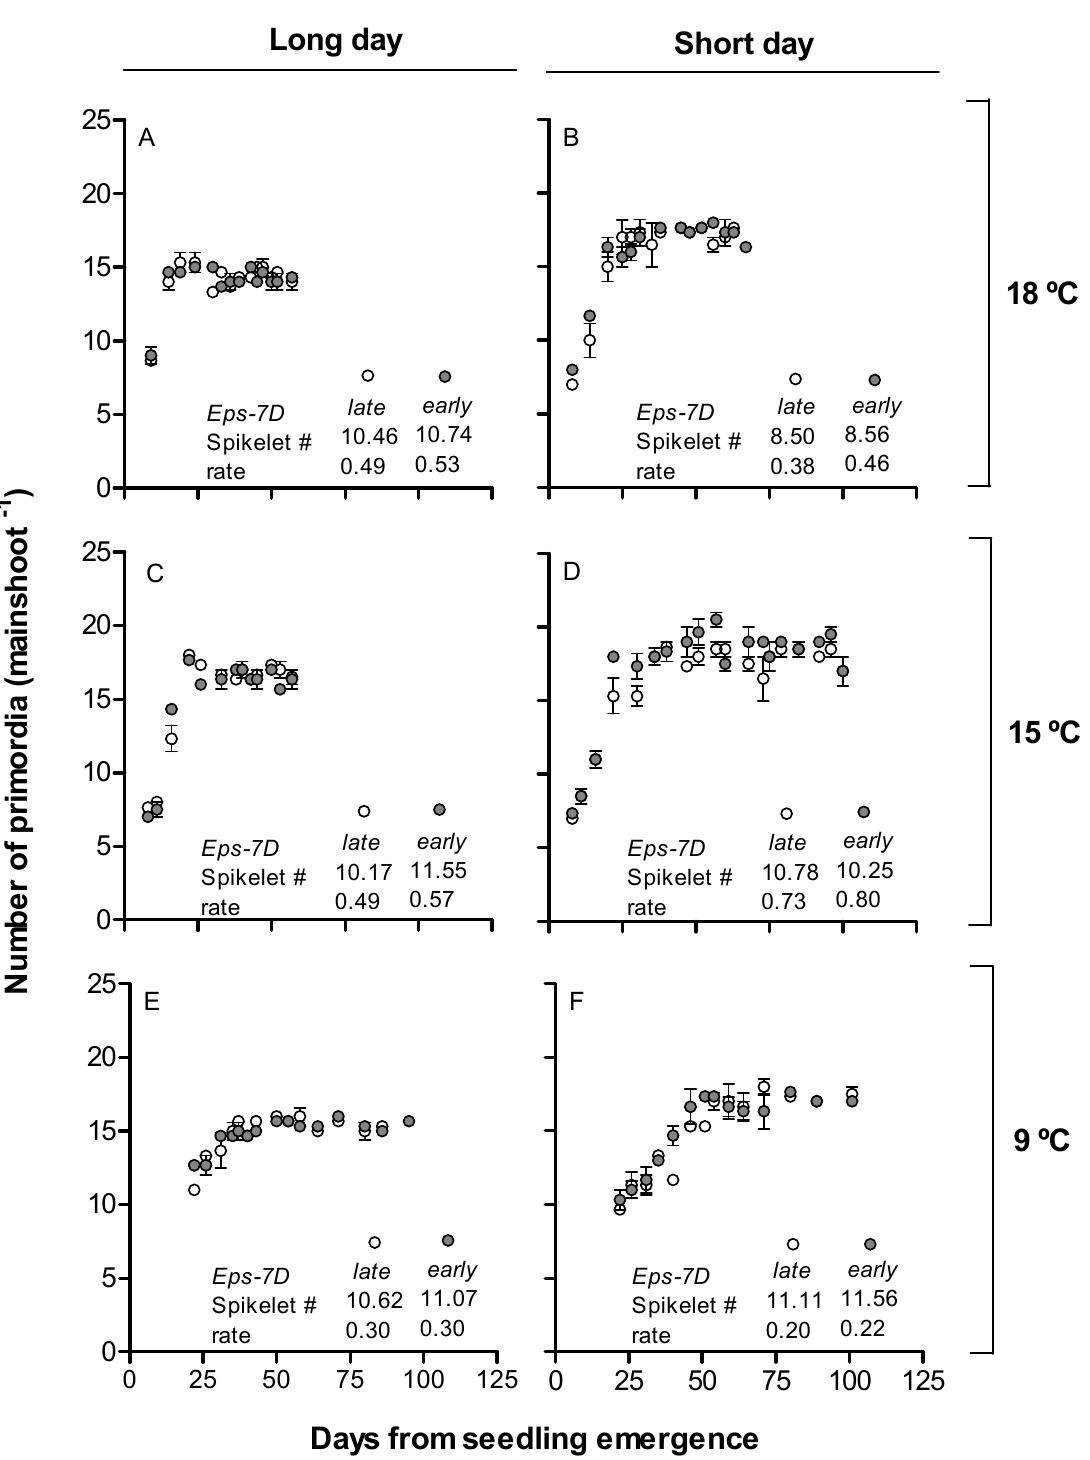
Figure 3. Relationship between number of primordia and days from seedling emergence for Eps-7D - late (open circles) and early (closed circles) under long ( A , C , E ) and short days ( B , D , F ) at 18 ( A , B ), 15 ( C , D ) and 9 °C ( E , F ). Inside each panel are the total number of spikelet primordia and rate of spikelet initiation (spikelets day − 1 ).